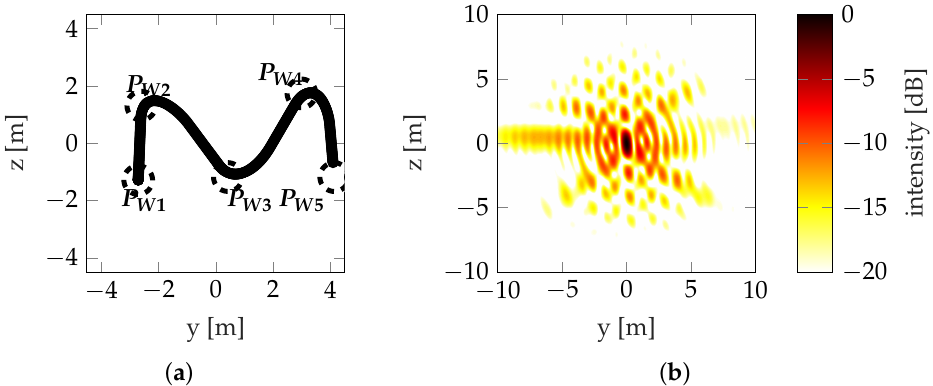
Figure 23. Best final situation—run #1—wide PSF range: ( a ) Trajectory with waypoints denoted by P W · and the acceptance circles marked with a dotted line. ( b ) PSF.